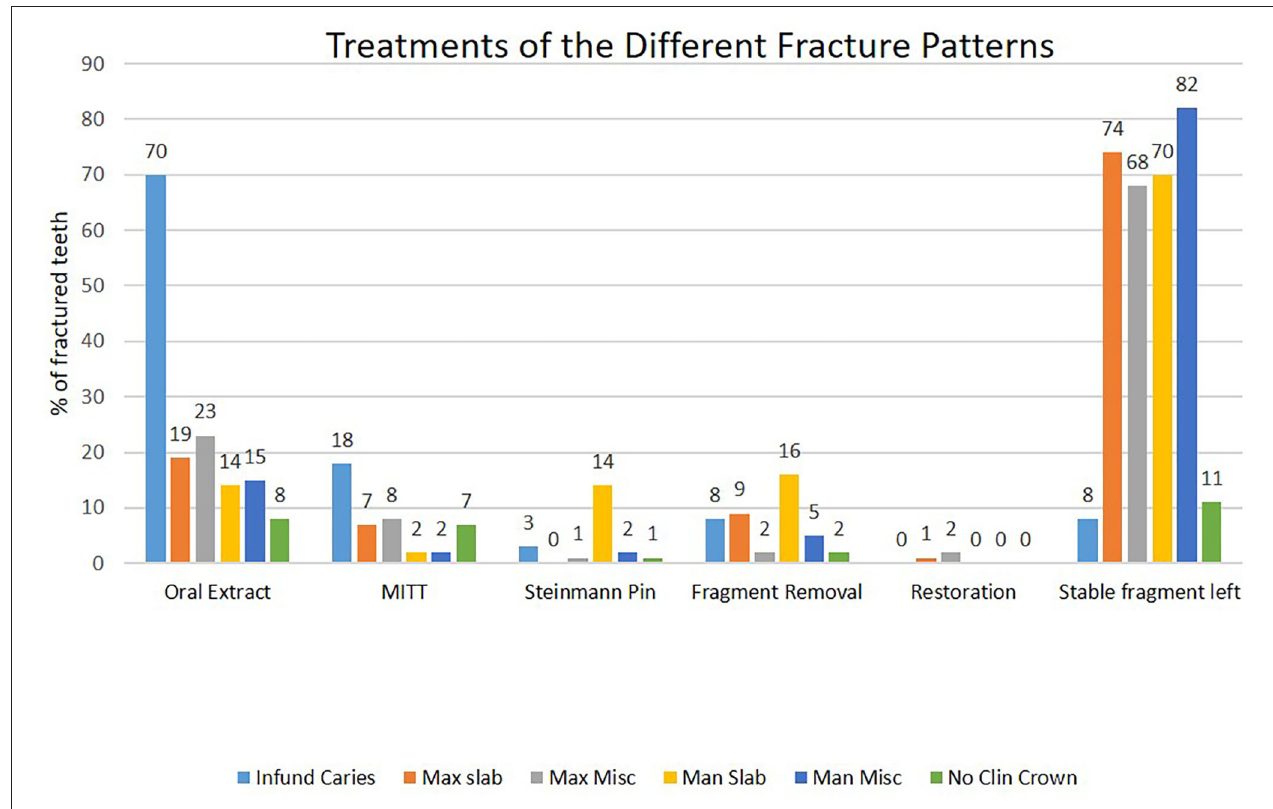
FIGURE 9 | Treatments of 486 fractured cheek teeth with six different fracture patterns: including oral extraction (Oral Extract), minimally invasive transbuccal technique (MITT), Steinmann pin repulsion (Steinmann pin), fragment removal, dental restoration (Restoration), or stable fragment left in situ . Infund caries, infundibular caries-related fracture; Max slab, maxillary first and second pulp horn fractures; Atypic max, atypical maxillary cheek teeth fracture patterns; Man slab, mandibular first and second pulp horn fractures; Atypic man, atypical mandibular cheek teeth fracture patterns; No Clin Crown, fracture with the absence of clinical